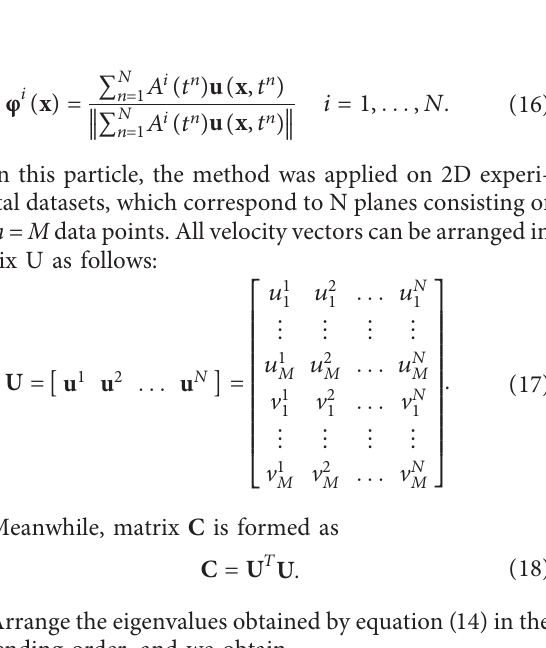
Figure 9: The single POD mode at 30g oscillation acceleration under 70% fill